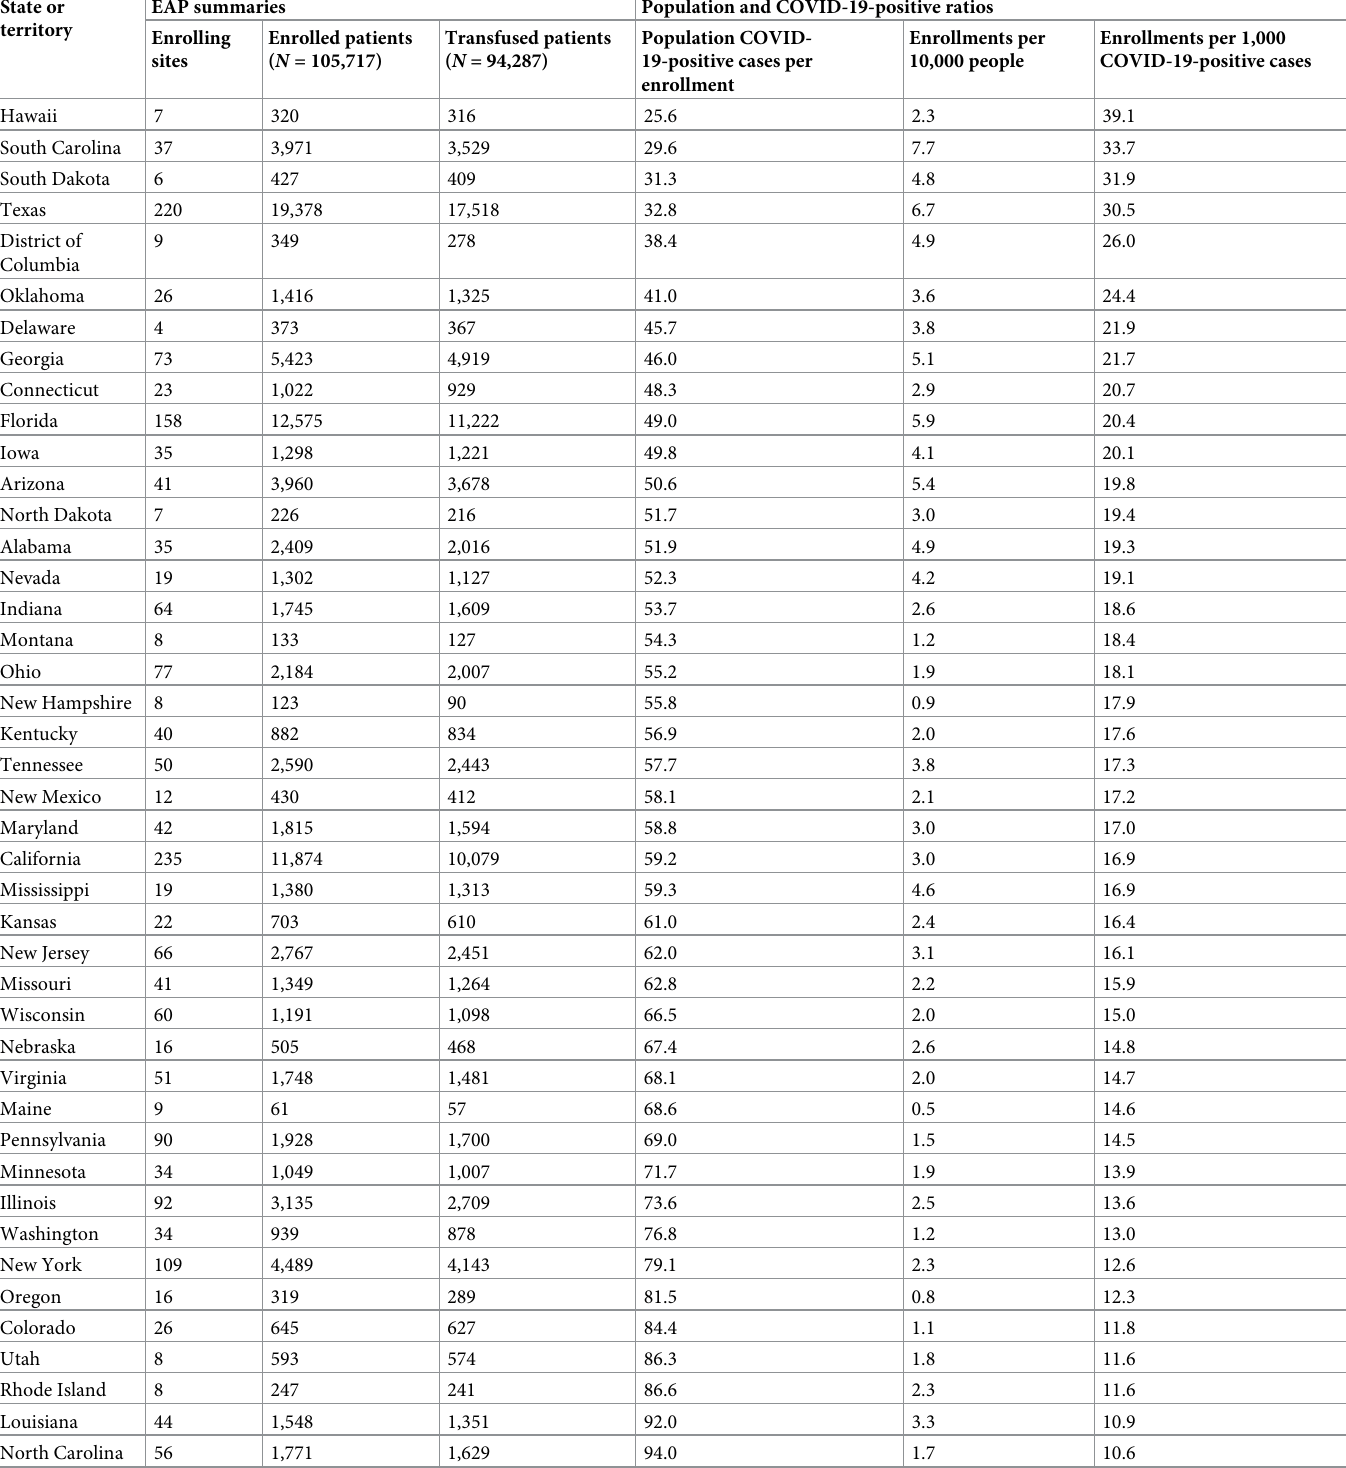
Table 2. Tabular summaries of patient enrollment in the US Expanded Access Program (EAP) for convalescent plasma and US COVID-19 cases during the EAP enrollment period, stratified by US state or territory, ordered by enrollments per 1,000 COVID-19-positive cases AU : PleasecheckthattheeditstothecolumnheadsinTable 2 captureyourmeaning : Ifnot ; pleaseeditasnecessary :